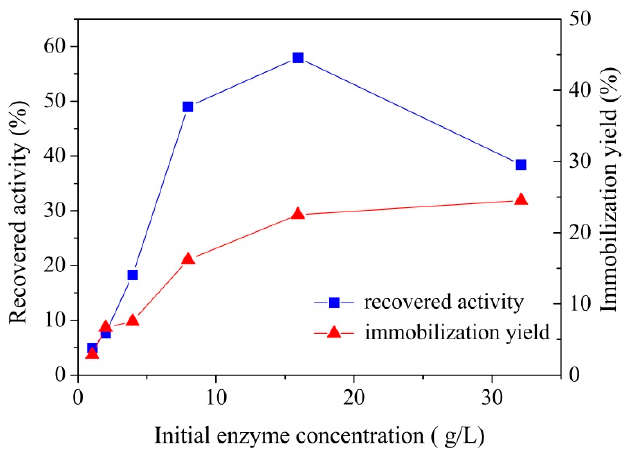
Figure 4. Effect of initial enzyme concentration on immobilized laccase recovered activity and laccase immobilization yield by absorption on MCCBs.